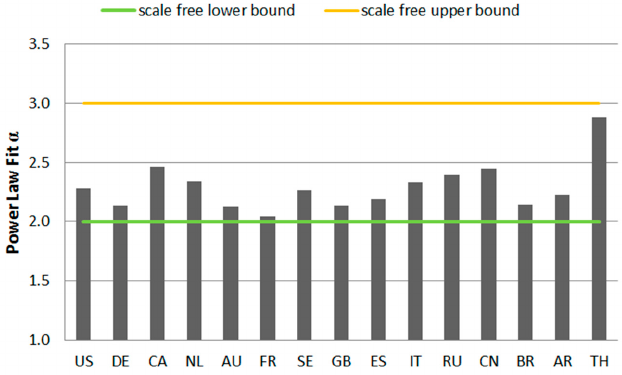
Figure 26. Power Law Fit α for Countries.